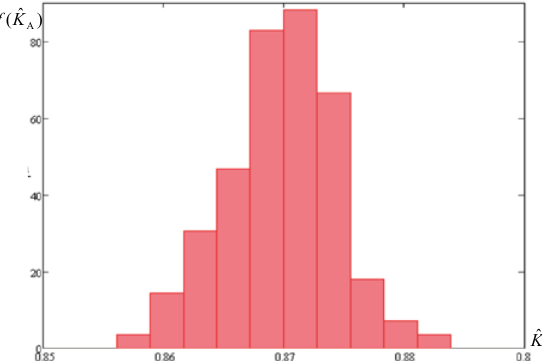
Fig. 6. Histogram of the ready-to-operate factor estimation for the case of normal distribution of operating time between failures and recovery